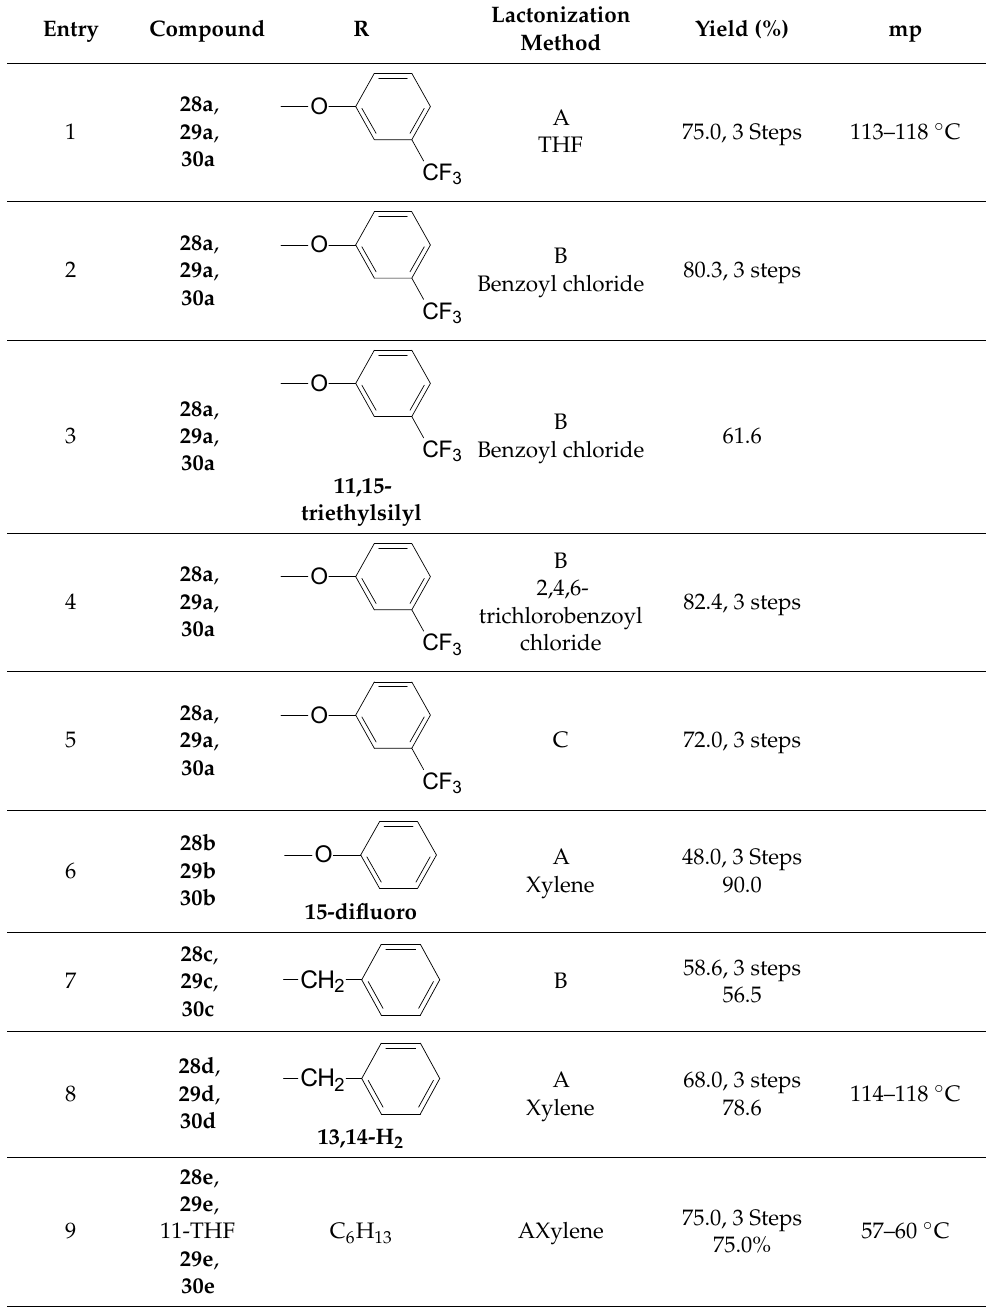
Table 1. Synthesis of 1,9-lactones of travoprost, tafluprost, latanoprost, bimatoprost, and unoprostone [26].